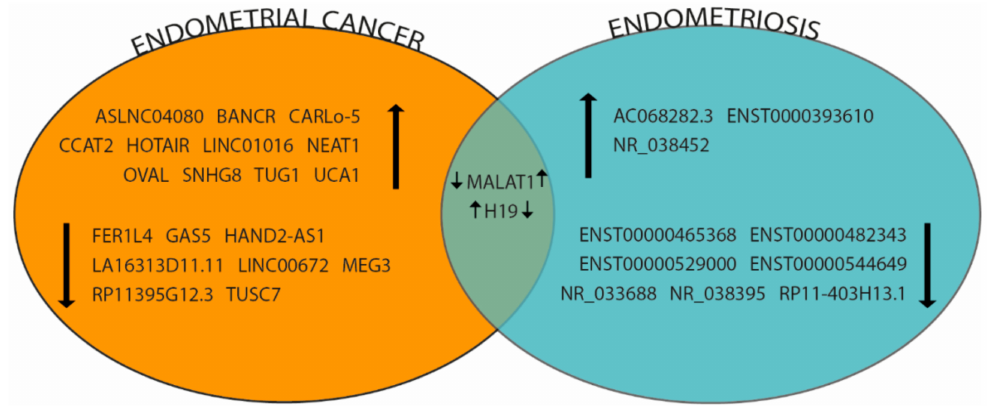
Figure 4. Representative lncRNAs involved in endometrial